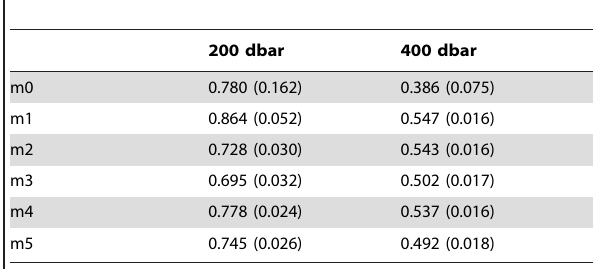
Table 5. Accumulation rates inferred from data from all 5 surveys (1992–2010).